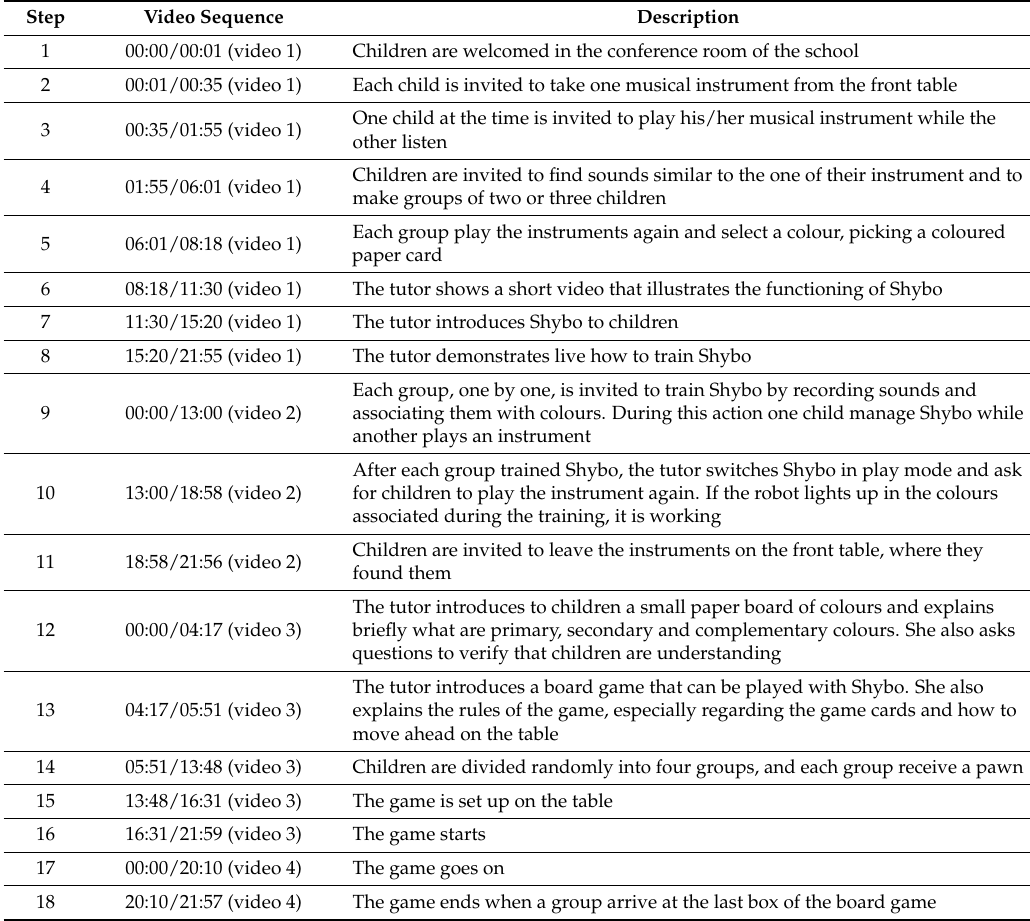
Table 2. The table shows the sequence of activities that characterised the playtest with children. In the video sequence column, the time of start and end are reported, together with the number of the video recording. This information is provided to help understand how the video coding process was carried out.